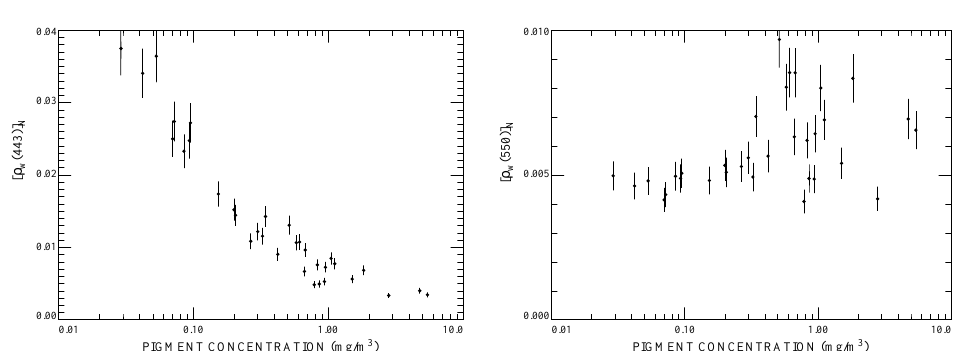
Figure 5. Normalized water-leaving reflectance as a function of pigment concentration (for Case 1 waters). Redrawn from Gordon et al. (1988) [21]. ( Left Panel ) 443 nm. ( Right Panel ) 550